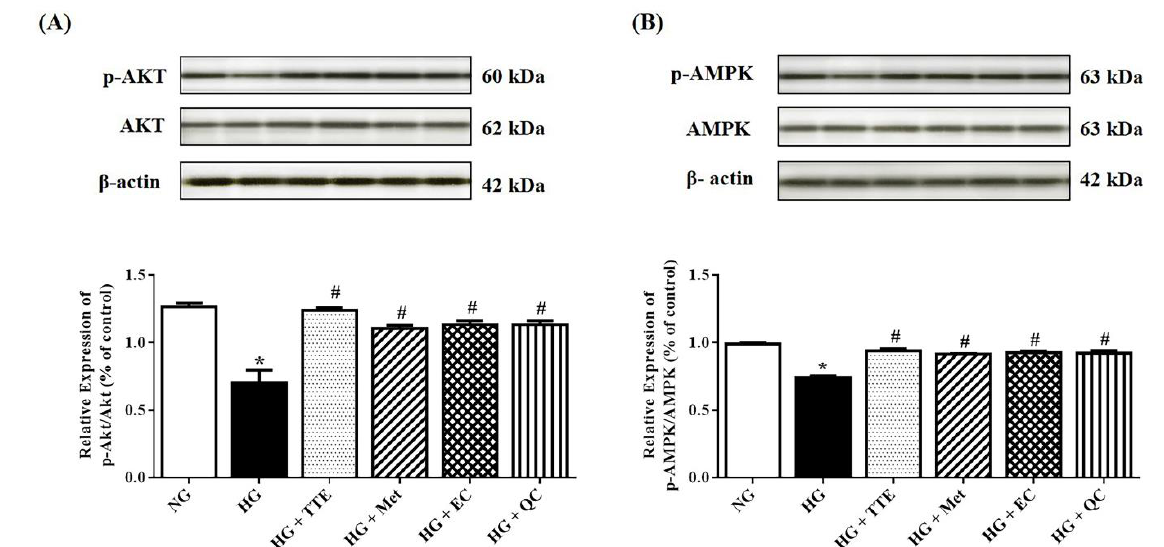
Figure 4. Effect of TTE on hepatic insulin signaling in HepG2 cells. ( A ) p-Akt and total Akt protein expression and ( B ) p- AMPK and total AMPK protein expression in HepG2 cells in each condition, including HG cells treated with 100 µ g/mL TTE (HG + TTE), HG cells treated with 2 mM metformin (HG + Met), HG cells treated with 100 µ g/mL epicatechin (HG + EC), and HG cells treated with 100 µ g/mL quercetin (HG + QC). A representative blot of p-AMPK, AMPK, p-Akt, and total Akt protein expression is shown on the top panel and quantification of relative protein expression in each fraction is presented on the bottom. Anti- β -actin antibody was used as loading control. Values shown are mean ± SEM ( n = 3), * p < 0.05 vs. the control group, # p < 0.05 vs. the HG group.